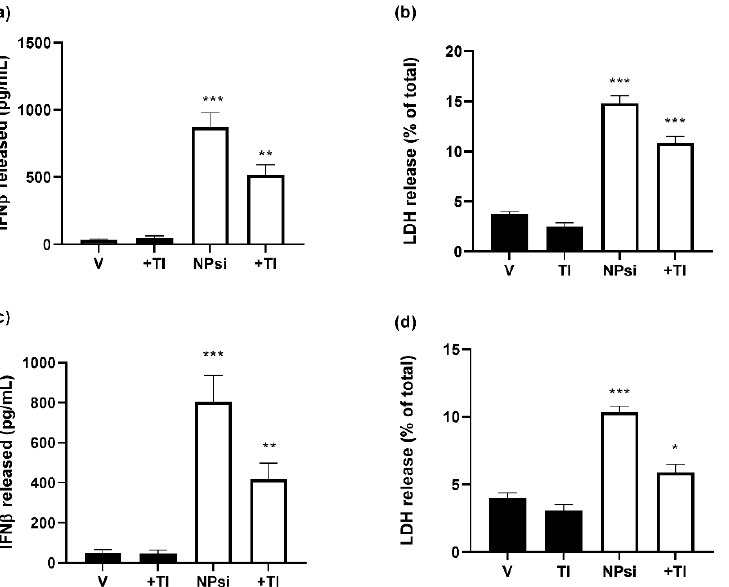
Figure 8. SCR-siRNA-induced production of IFN β and cell death in LNCaP ( a , b ) and PC3 ( c , d ). Cells were treated with nanocomplexes formed by AMC11(1 µ M) and SCR-siRNA (NPsi, 100 nM) for 72 h, and IFN β production ( a , c ) and cell death ( b , d ) were determined in presence and absence of a TLR3 inhibitor (TI, 10 µ M). Data are expressed as mean ± SEM from 6 to 12 experiments. * p < 0.05; ** p < 0.01; *** p < 0.001 compared with control-treated cells.